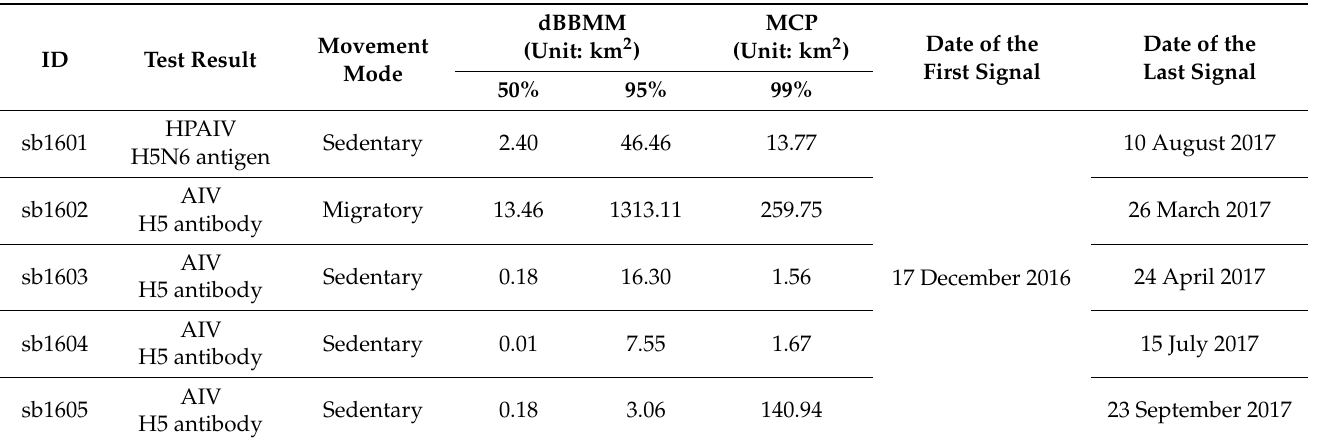
Table 2. Summary of home range and a behavior net squared displacement analysis on spot-billed ducks either with highly pathogenic avian influenza (HPAI) H5N6 virus or with H5-specific